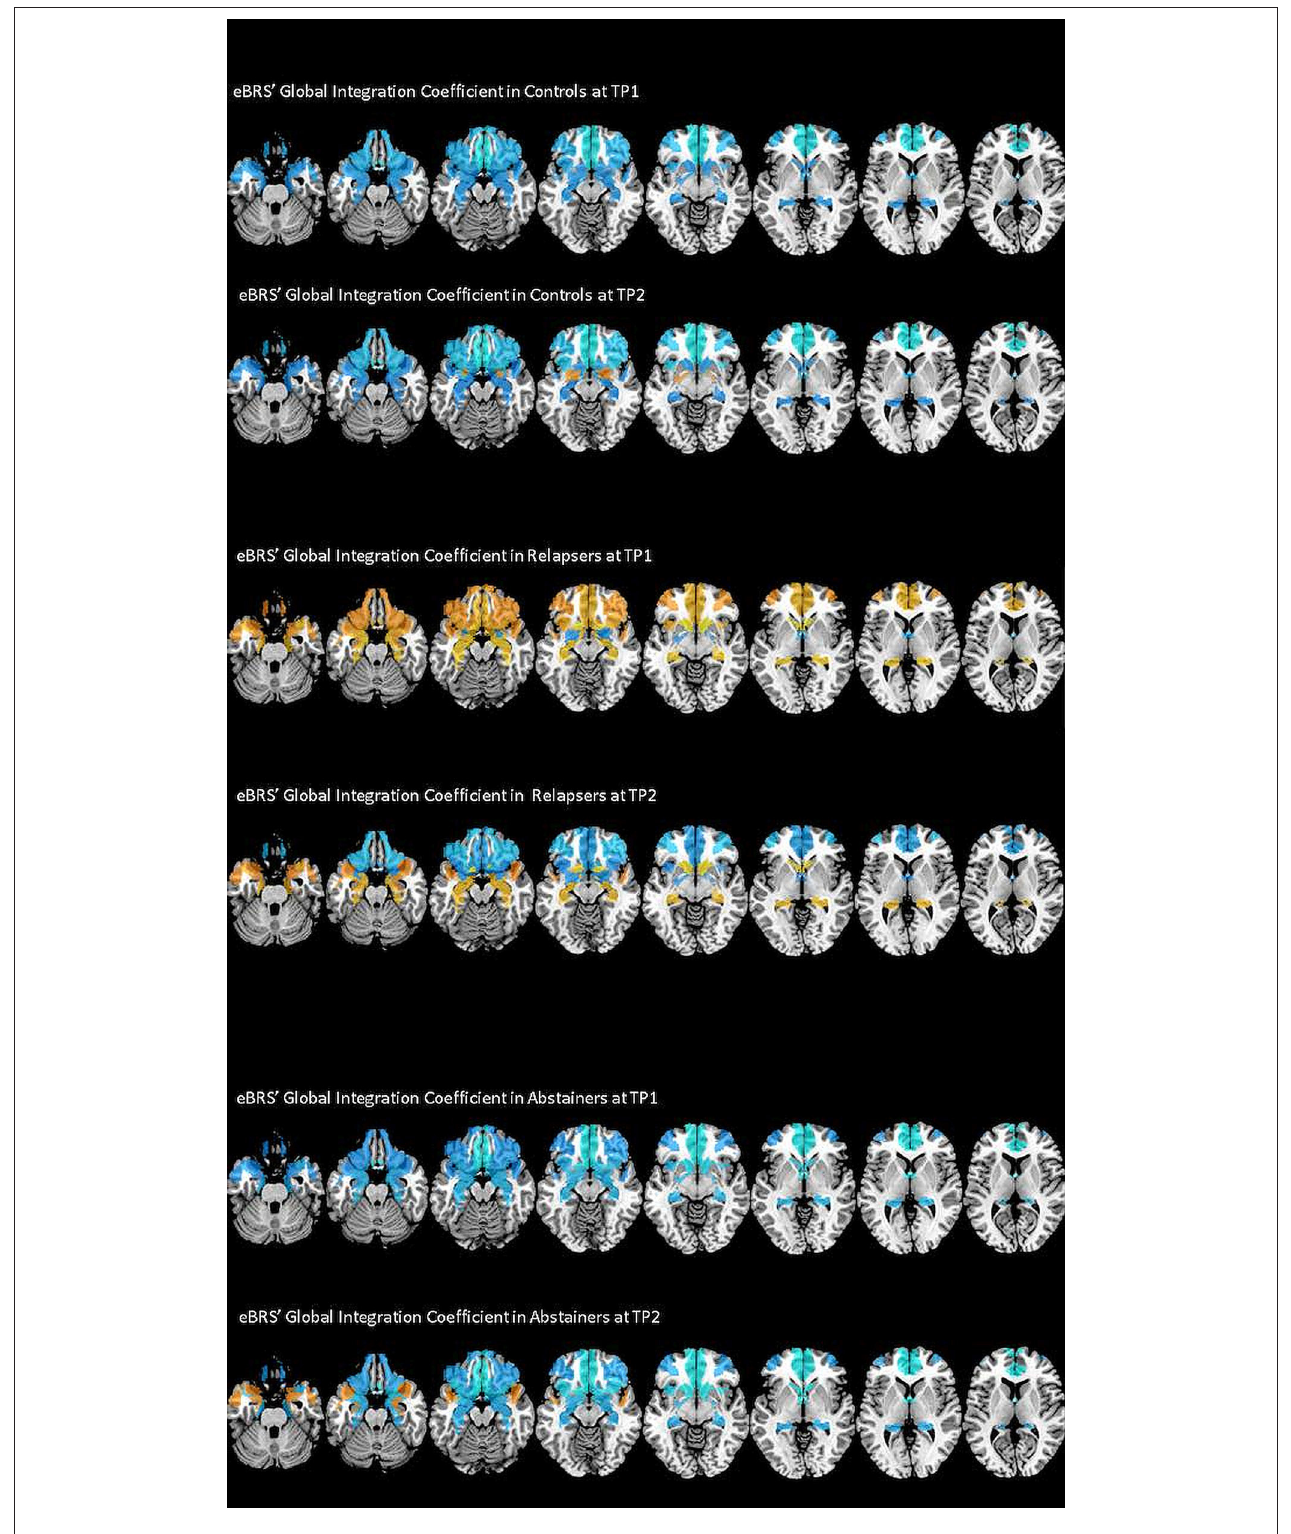
FIGURE 3 | The degree of global integration of the nine eBRS regions at 1 month into abstinence ad 3 months later. eBRS regions with a positive GIC value are coded in orange – yellow (range 0–0.05) and eBRS regions with a negative GIC value are coded in blue – light blue (range 0–0.1). When compared with the controls and abstainers, relapsers showed over-integration ( = positive GIC values) in almost all eBRS regions, while the eBRS in the two other groups was mostly disconnected ( = negative GIC values) from the global across-community interaction.